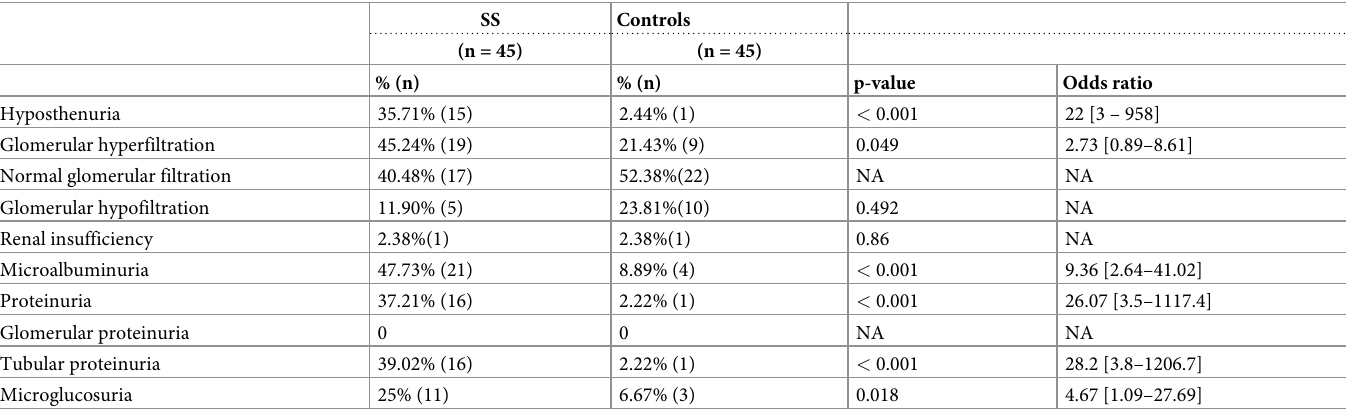
Table 5. Comparison of disturbances of nephropathy biomarkers between sickle cell anemia patients and age- and sex-matched controls. SS